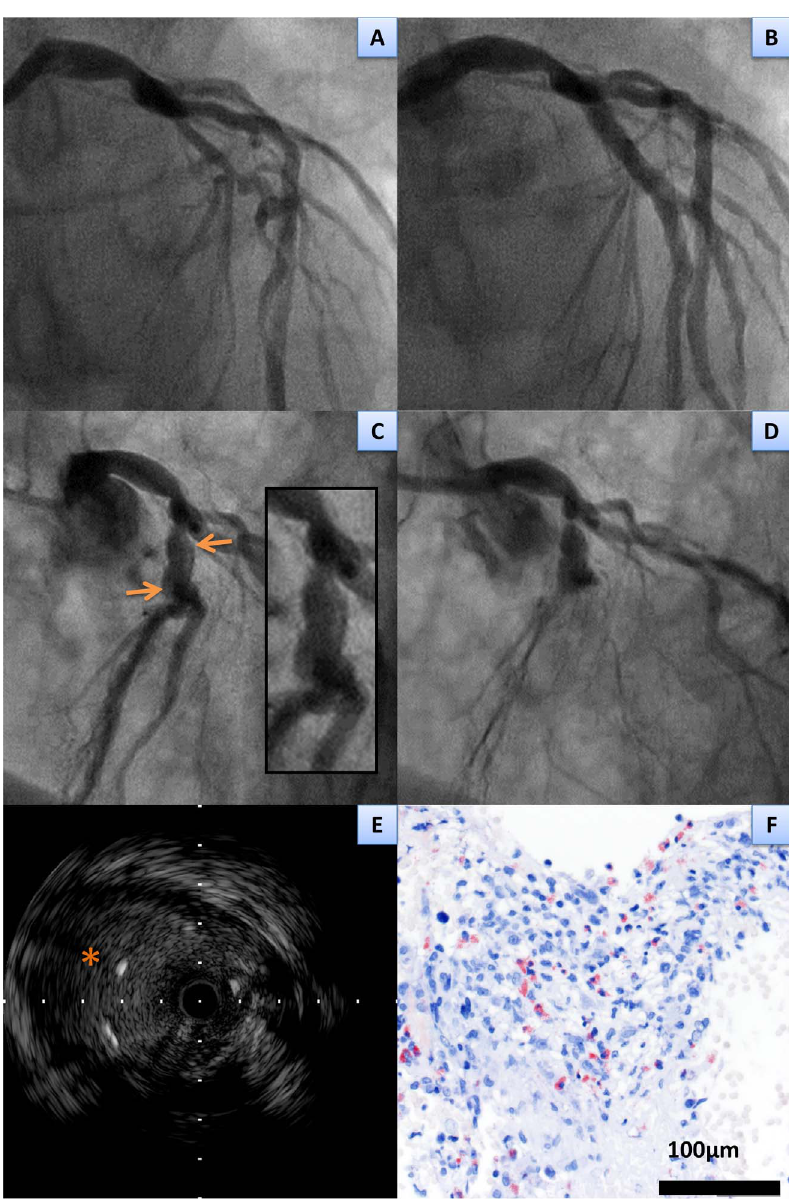
Figure 3. A representative case of very late stent thrombosis with eosinophilic infiltrates in the aspirated thrombus retrieved from lesions with peri-stent contrast staining and incomplete stent apposition. A , B Pre and post coronary angiography at the index sirolimus-eluting stents implantation (modified T stenting) demonstrated bifurcation lesion at the left anterior descending coronary artery. C , peri- stent contrast staining ( arrows ) was found by follow up angiography 813 days after the index procedure. D , very late stent thrombosis occurred at 1033 days after the index procedure. E , Intravascular ultrasound demonstrated intra-stent thrombus and incomplete stent apposition with positive arterial remodeling ( asterisk ). F , The histopathological image of the aspirated thrombus showed inflammatory infiltrate with eosinophils (19.4% out of total white blood cells) (Luna